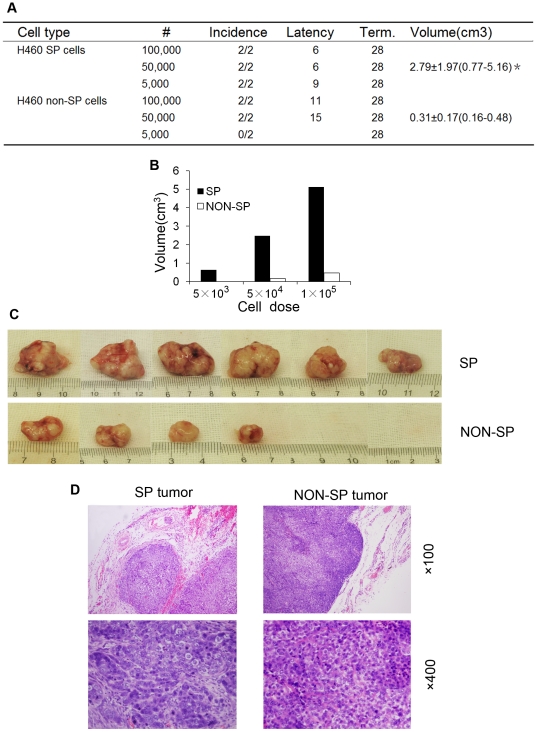
High tumorigenicity in SP cells.A, Table presentation of the tumorigenic potential of H460 SP and non-SP cells. Three parameters of tumorigenicity, i.e., tumor incidence, latency, and volume (*P<0.01) were shown. All animals were terminated (term.) 28 days after implantation. B, The SP cells regenerated larger tumors than corresponding non-SP cells at every cell dose. C, Gross tumor images when tumors were harvested at day 28 after s.c. injection of the SP and non-SP cells into NOD/SCID mice. D, Representative HE-stained photomicrographs of SP and non-SP tumors.